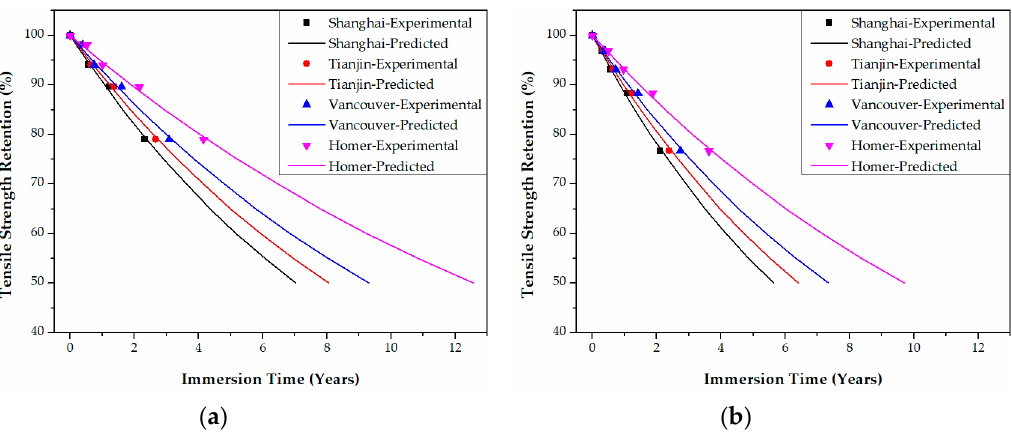
Figure 22. Life prediction of the tensile strength for epoxy-based CFRPs (58% strain) immersed in distilled water ( a ) and seawater ( b ) in the four cities, respectively.